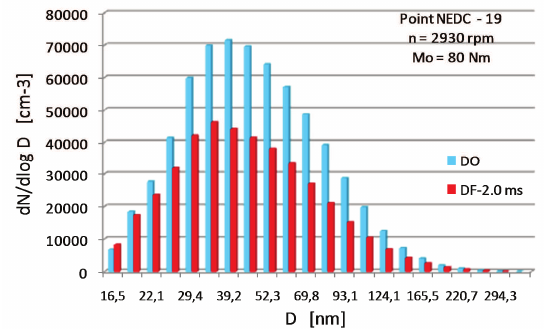
Fig 10. Comparison of fractional distribution of particulate matter dN/dlogD of the Fiat 1.3 MultiJet engine fueled traditionally and in dual fuel system: point 19 according to NEDC test, n = 2930 rpm, Mo = 80 Nm, opening time of gas injectors 2.0